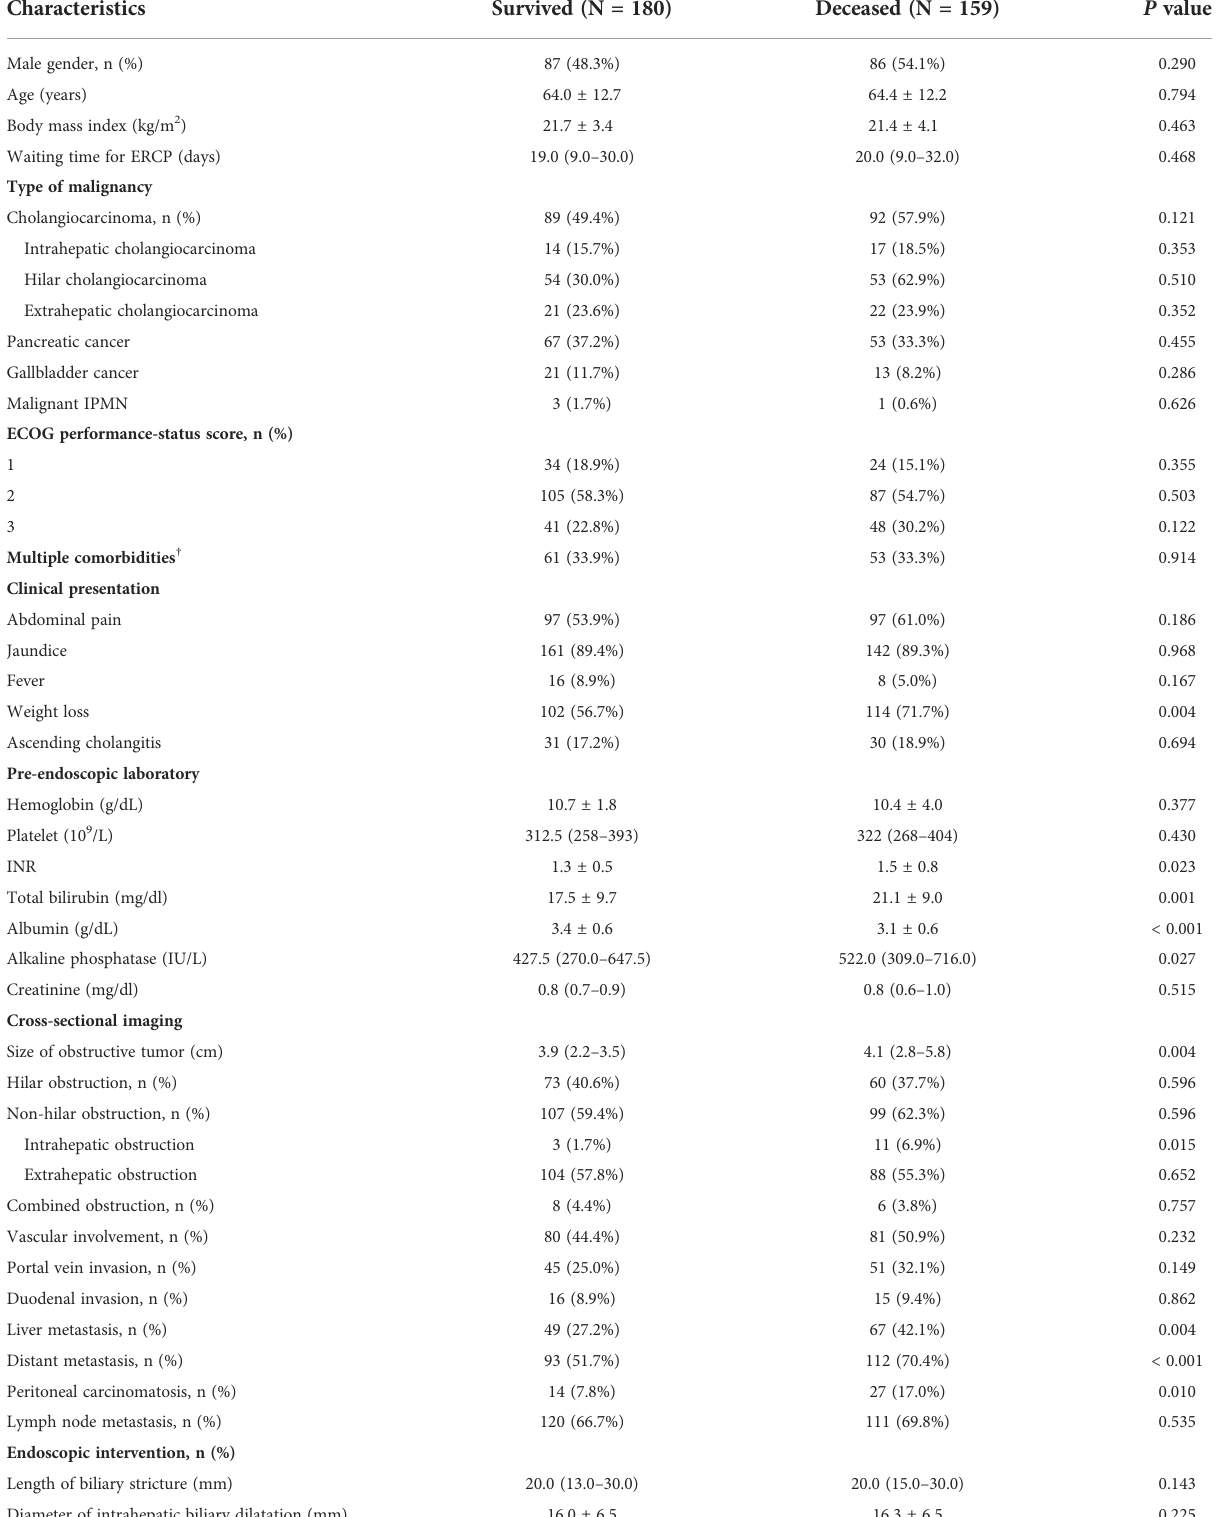
TABLE 2 Baseline characteristics and endoscopic intervention among the surviving and non-surviving groups in the derivation cohort.